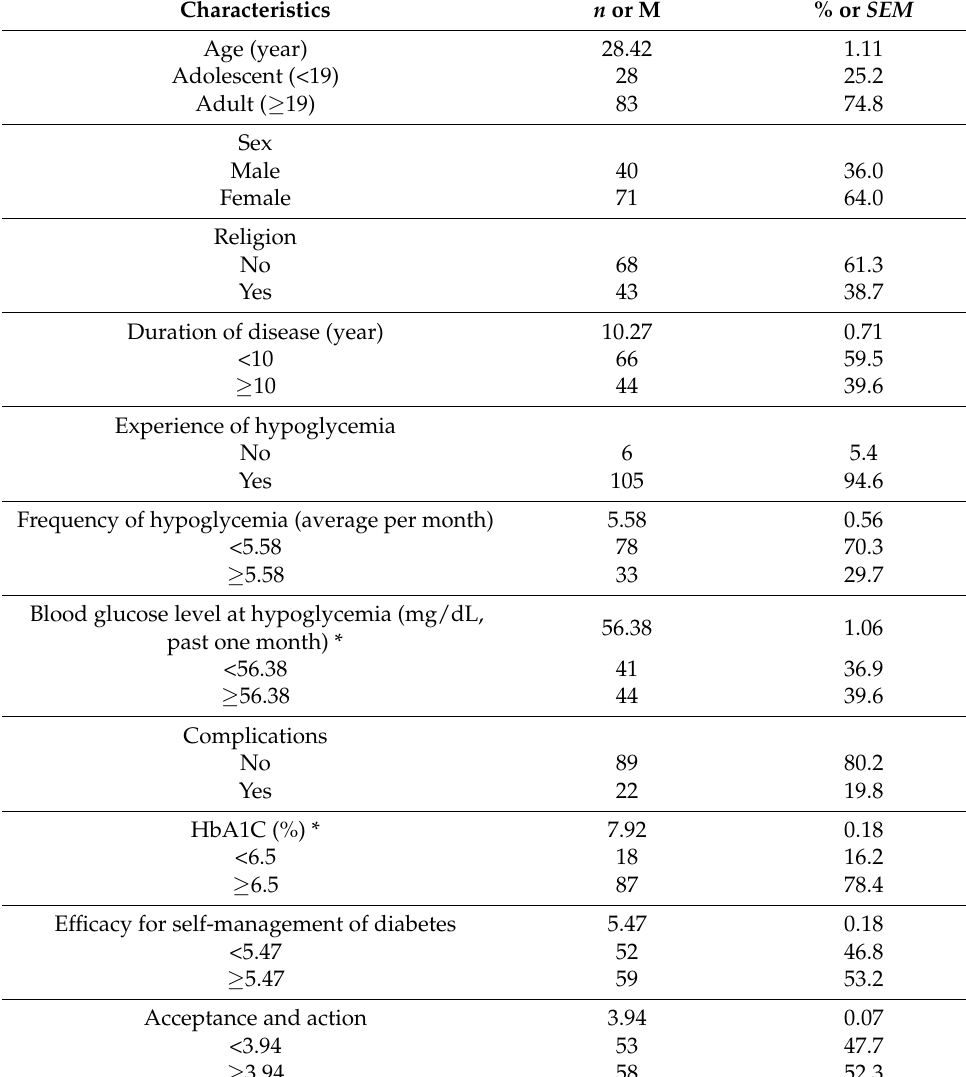
Table 1. Characteristics of the Participants ( N =